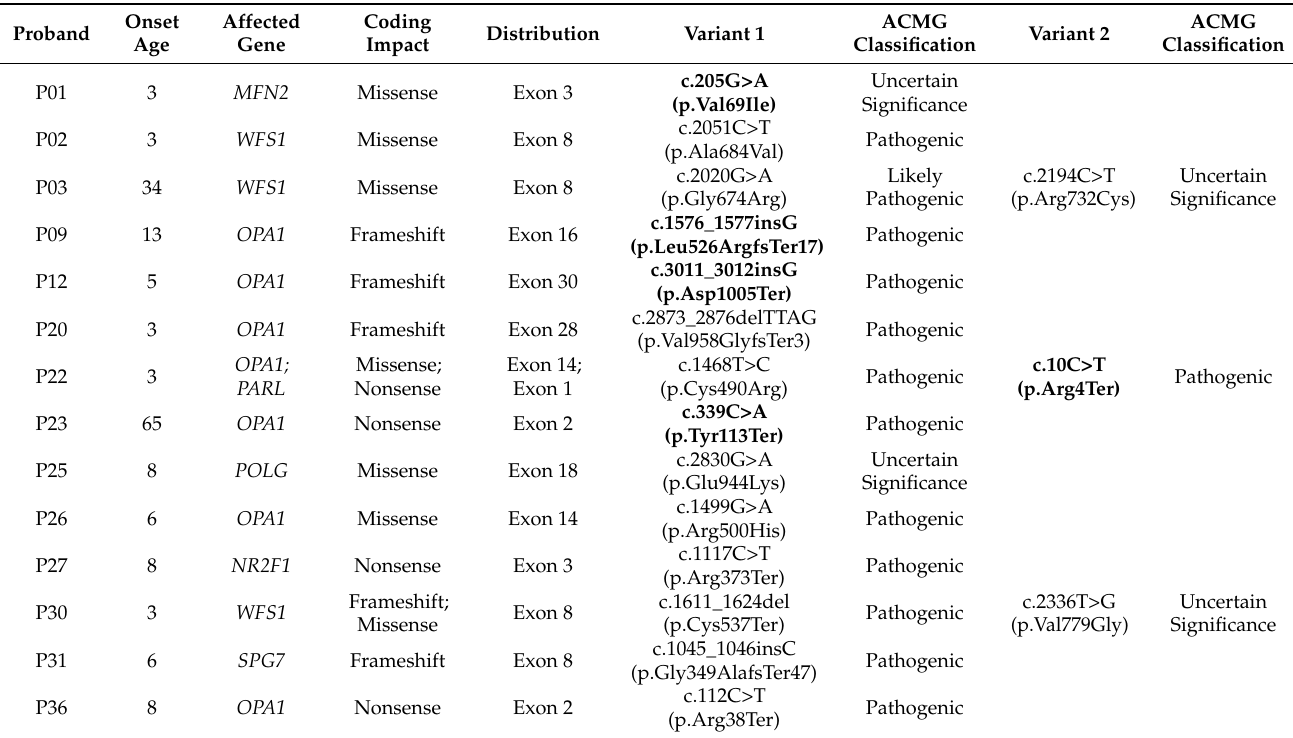
Table 1. The list of disease-causing variants in 14 probands in our cohort.